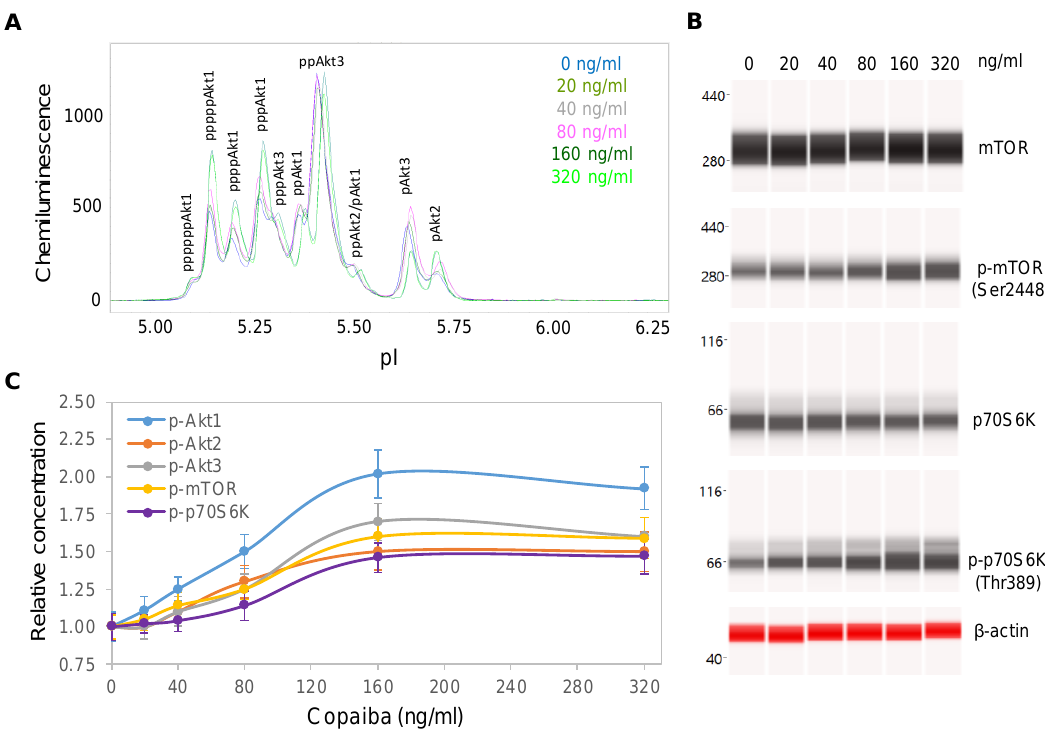
Figure 3. Dose-dependent positive regulation of the PI3K/Akt/mTOR signaling pathway by copaiba essential oil. ( A ) Pan-Akt profiles and ( B ) expression levels of the mTOR and p70S6K phosphoisoforms as functions of copaiba essential oil dose. ( C ) Relative concentrations of the Akt1 (blue), Akt2 (orange), Akt3 (gray), mTOR (yellow), and p70S6K (purple) phosphoisoforms as functions of copaiba essential oil dose. The relative concentration describes the fold change in a protein phosphoisoform after treatment compared to the control condition. The error bars are the standard deviations of six repeated measurements per experimental condition. SH-SY5Y cells were treated with various concentrations of copaiba essential oil for 30 min.